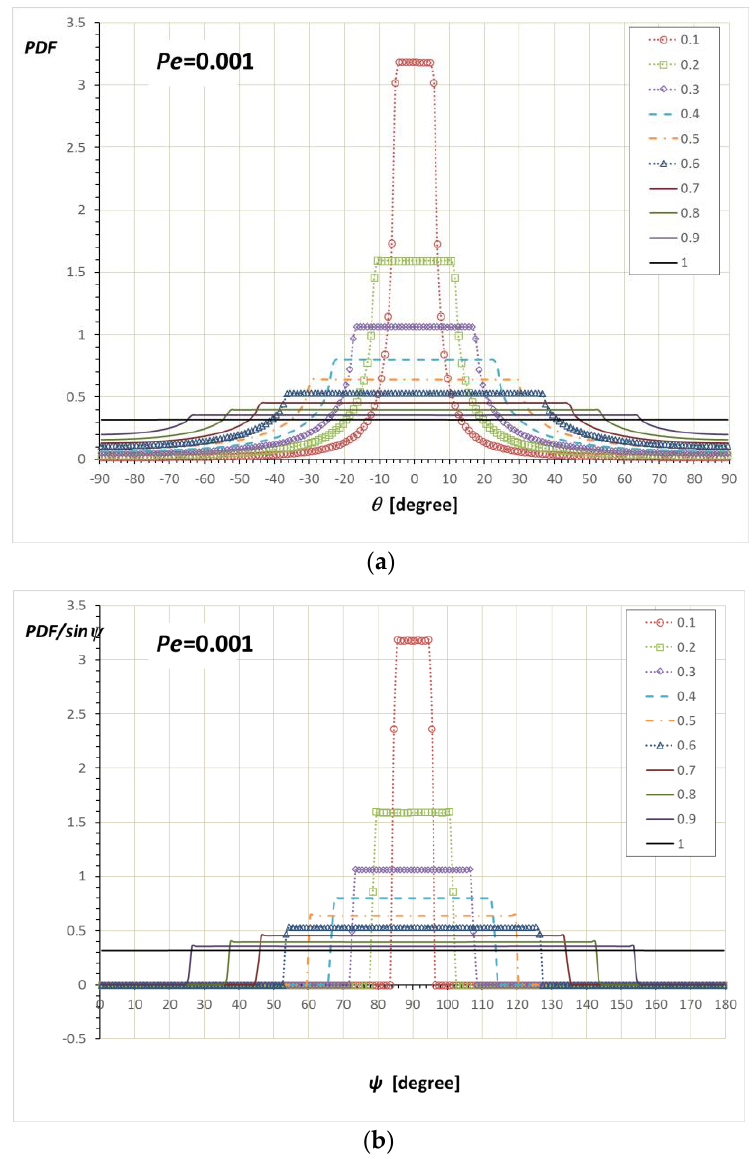
Figure 8. Simulation results for the ( a ) PDF( θ ) and ( b ) PDF( ψ )/sin ψ at Pe = 0.001 with various α / a .